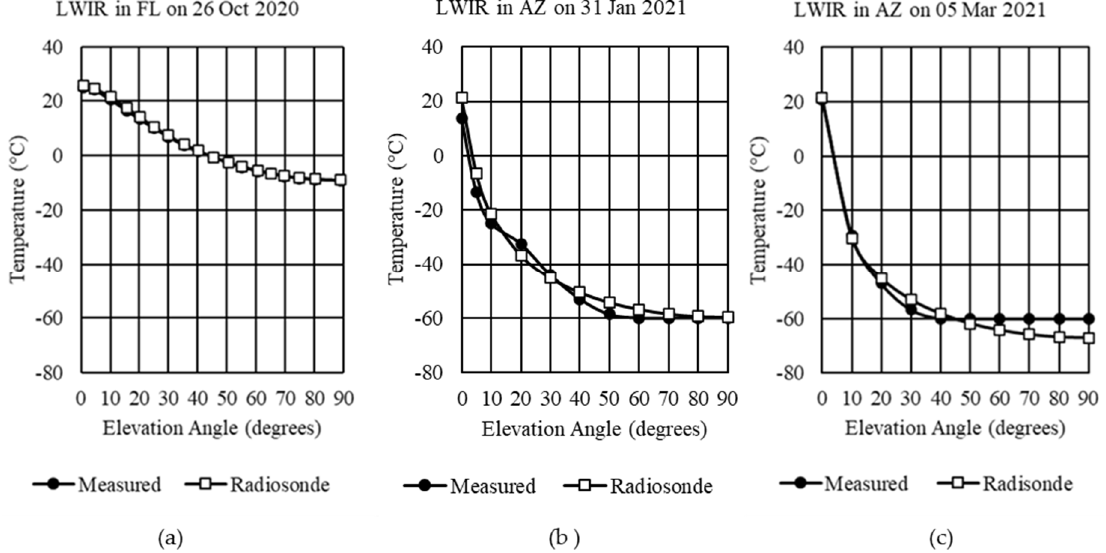
Figure 6. LWIR measured sky temperatures compared with daily radiosonde data: ( a ) Example 1 in Cape Canaveral, Florida; ( b ) Example 2 in Tucson, Arizona; ( c ) Example 3 in Tucson, Arizona.